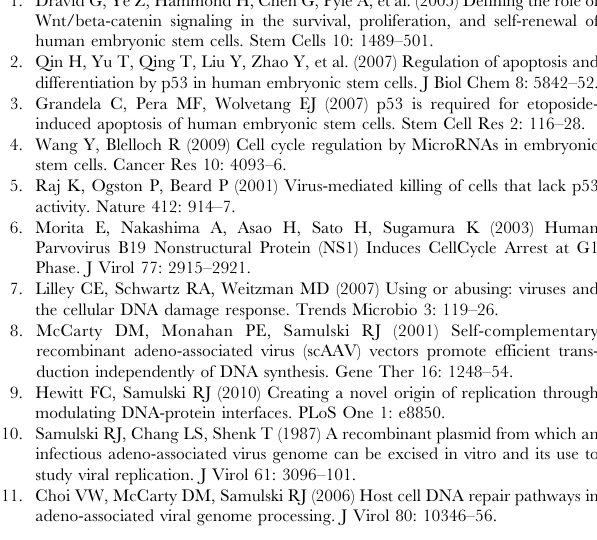
value . 0.5). (C) H9 hESCs deficient for p53 were transduced with transduced by rAAV3B-gfp (100,000 viral genomes/cell) and images of colony integrity and GFP fluorescence are provided at the time points following transfection. Figure S5 Densitometry Analysis of Western Blots. The indicated Western blotting experiments were analyzed for a relative abundance using a storm scanner and Image Quant 5.2. Internal loading controls were used for normalization. (ND indicates no signal detected and NT represents no treatment). (EPS) Figure S6 Transcript Abundance of Apoptotic Effectors. H9 hESCs were treated with rAAV3B-CMV-egfp (1e5 viral genomes/cell) or equal volume of PBS. RNA from treated cells was harvested, converted to cDNA and copy number of the indicated transcripts was determined by Q-PCR. Lamin B2 transcript abundance was used for normalization to cell number and the data is presented as the normalized transcript abundance of the rAAV treated cells divided by the vehicle control. In all cases the transcript abundance change in cells treated with AAV was not significantly different than the non-treated (NT) controls (p-value . 0.2). Figure S7 Quantitation of the DNA Microinjection Experiment. For each of the indicated injection regimens approximately 100 hESCs were injected with the indicated DNA oligonucleotide (oligo) as described in the results and methods. Two hours post-injection rhodamine positive cells were tallied and are presented as a percentage of the total injected. (* indicates p- value ,